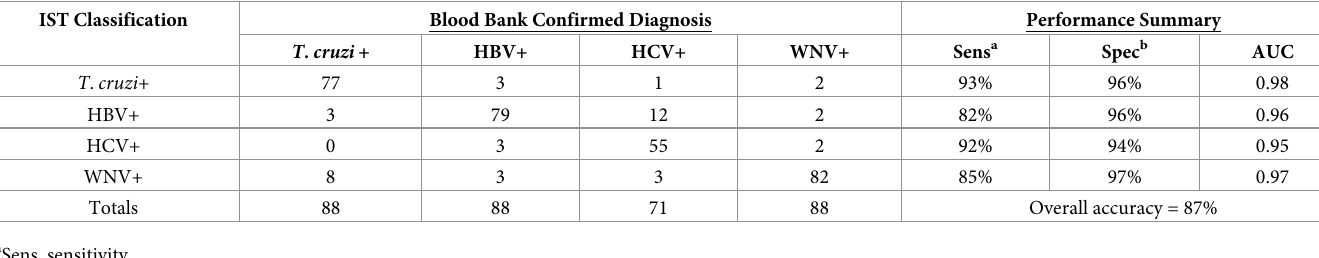
Table 5. Confusion matrix and performance estimates of the multiclass prediction model.